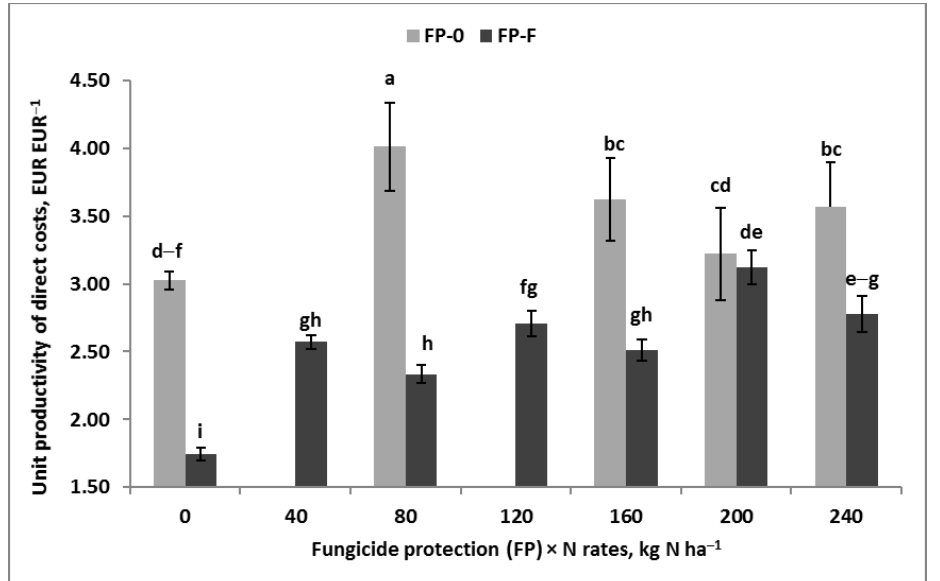
Figure 11. Effect of winter wheat protection with fungicides and rates of fertiliser nitrogen on unit productivity of direct costs. Similar letters in the column means a lack of significant differences using Tukey’s test. The vertical bar in the column refers to the standard error of the mean—simulation 2022.